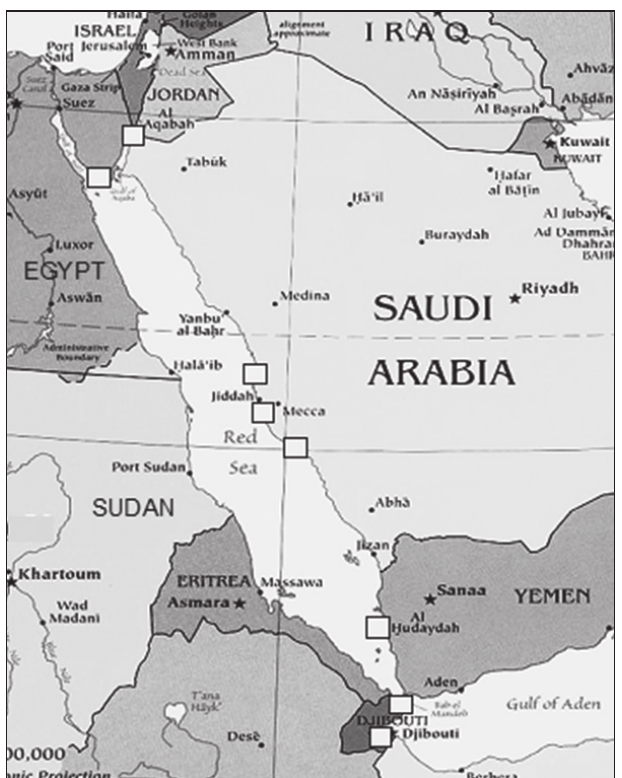
Figure 1. Map of the Red Sea and Gulf of Aden. Squares indicate the coral reef sites examined in the present